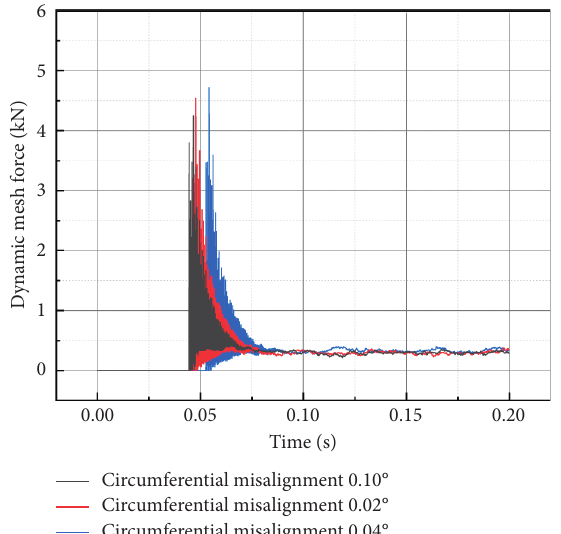
Figure 21: The comparison of meshing force of spline coupling with different circumferential misalignments φ under identical loading